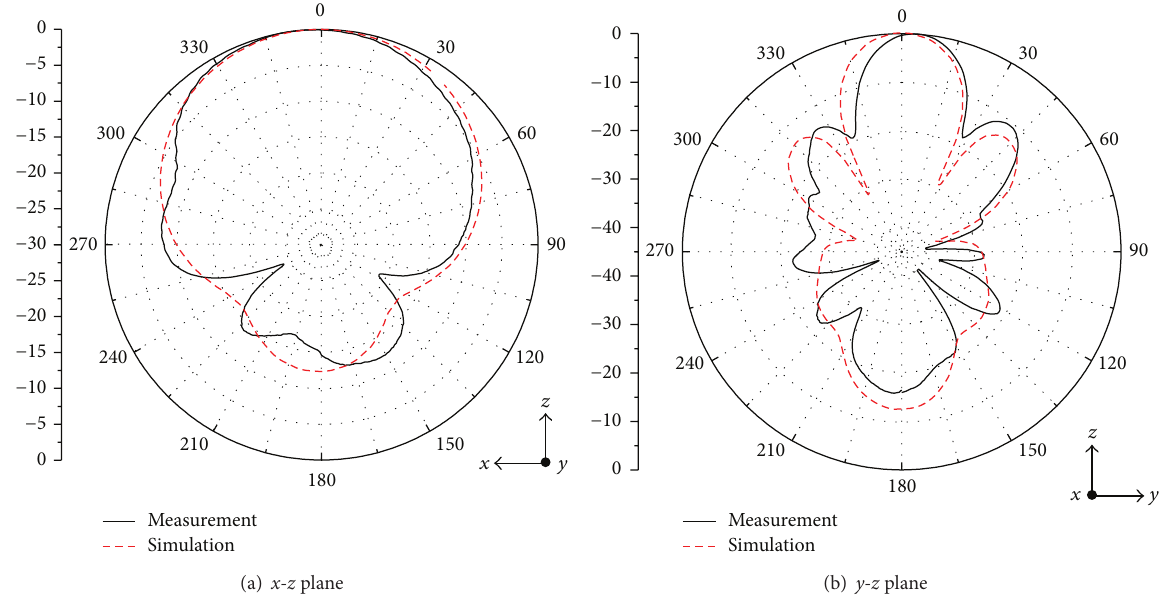
Figure 11: Measured and simulated LHCP radiation patterns.